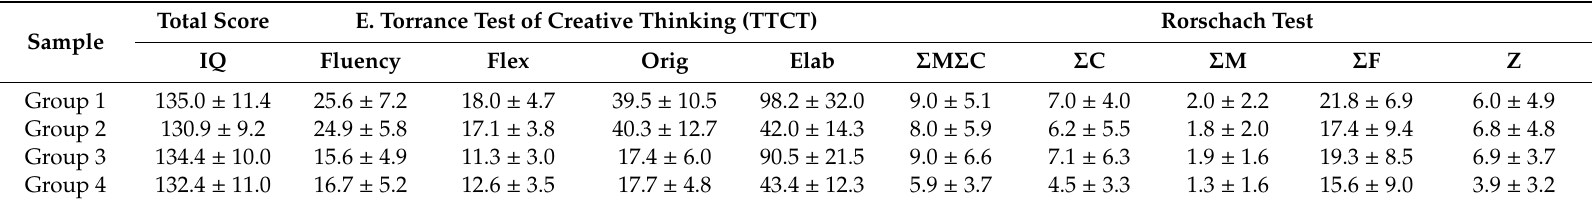
Table 1. Average results of intelligence, creativity, and adaptive personal resources in